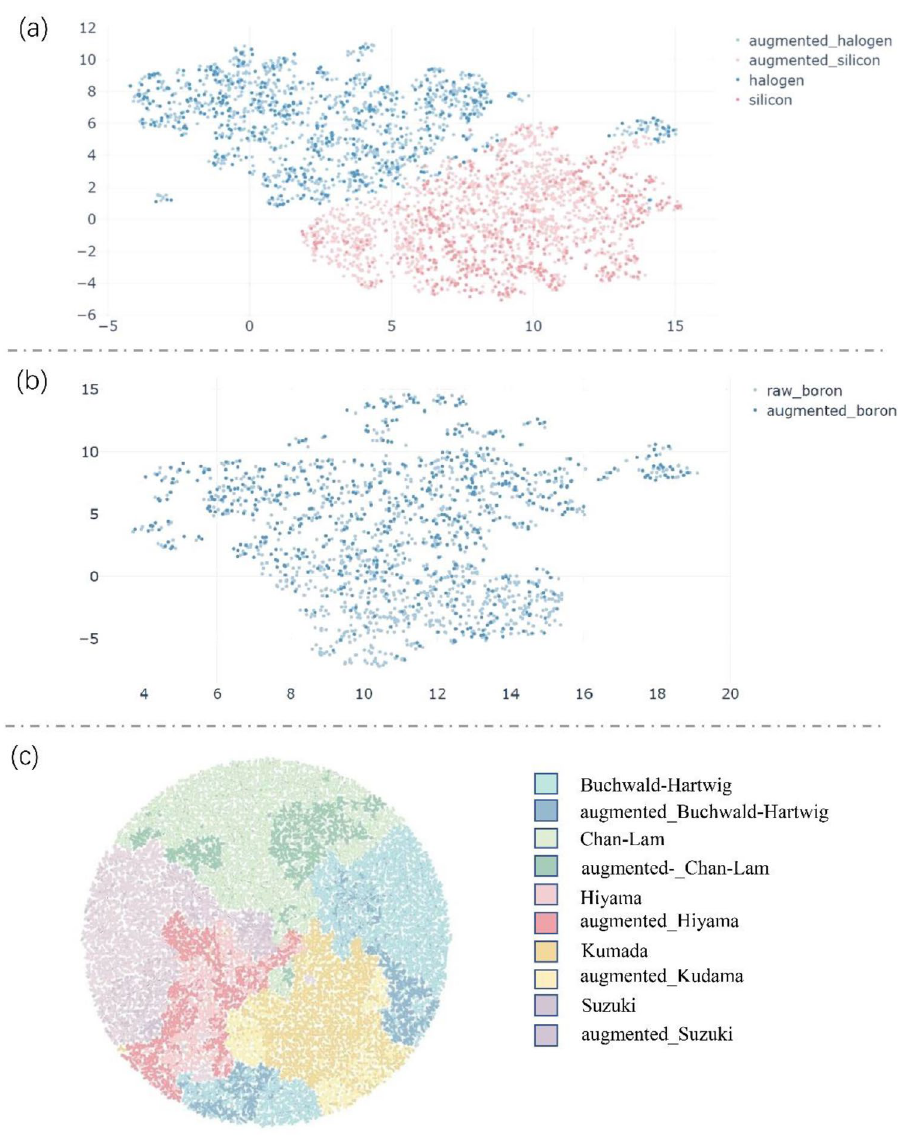
Figure 3. UMAP plot of molecules from raw data and virtual augmented data and TMAP plot of rxnfp of reactions from raw data and virtual augmented data. ( a ) UMAP map of Hiyama coupling reaction before and after virtual data augmentation. ( b ) UMAP map before and after virtual data augmentation of Chan-Lam coupling reaction. ( c ) TMAP before and after virtual data augmentation of five classic coupling